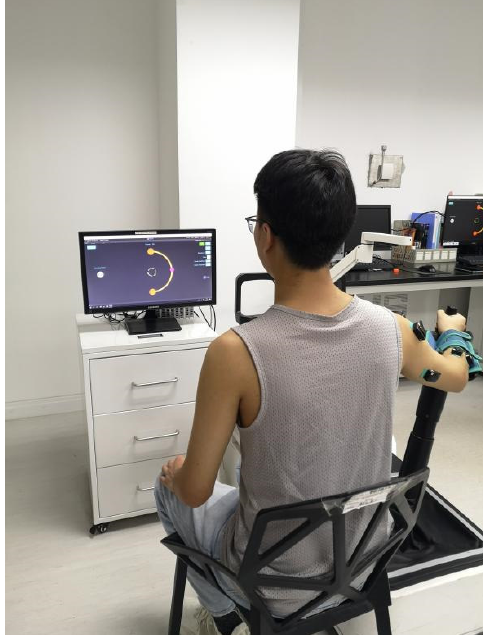
Figure 1. The upper limb movement experiment based on the rehabilitation robot. In this study, the activities of seven muscles, including the anterior deltoid (DA), posterior deltoid (DP), triceps brachii (TI), biceps brachii (BI), extensor carpi radialis (ECR), flexor carpi radialis (FCR), and brachioradialis (BIO), were recorded through a